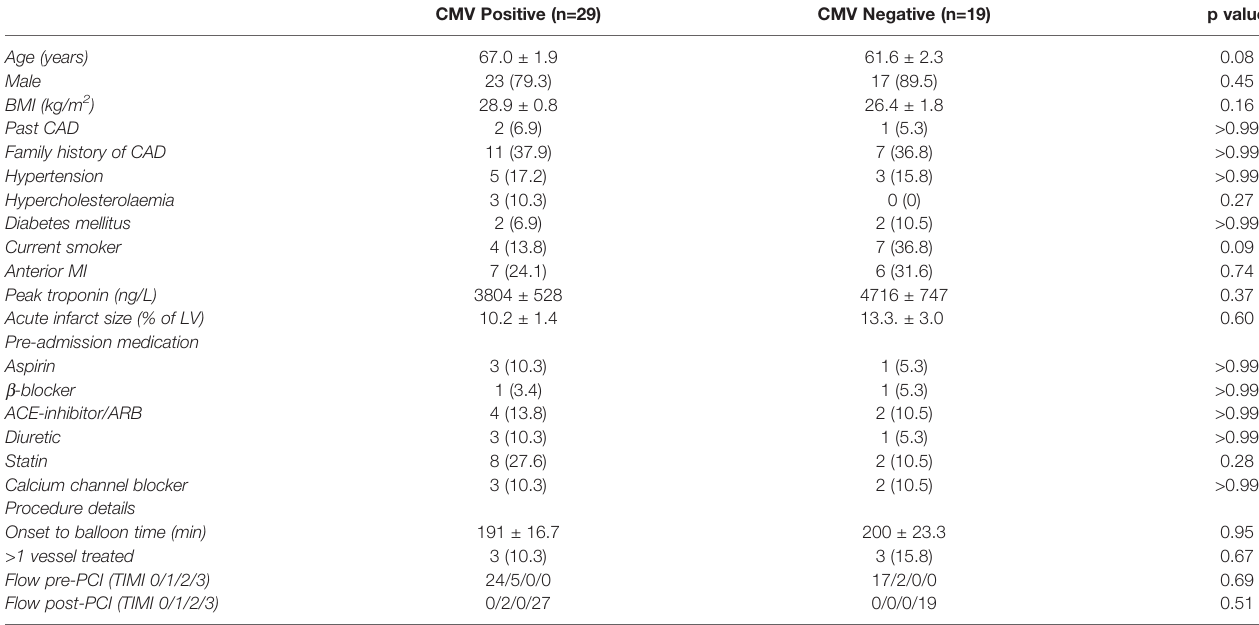
TABLE 1 | Demographic characteristics of all patients with a cMRI both at 2-7 days and at 12 weeks, split into CMV positive and negative